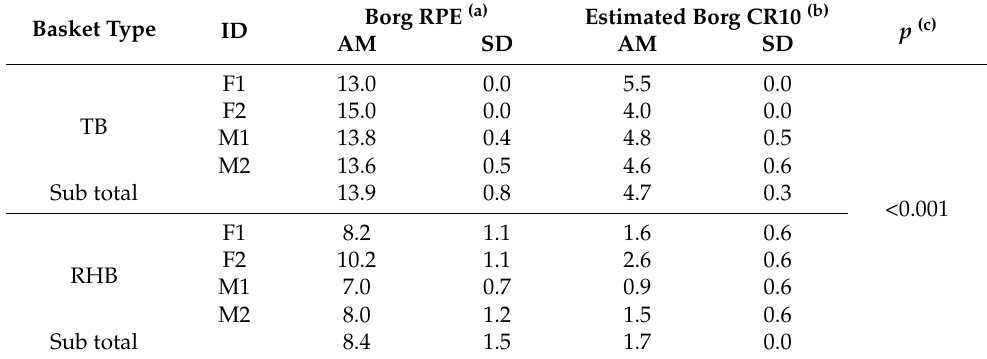
Table 2. Results of the subjective discomfort levels according to the Borg RPE and Borg CR10 scales.